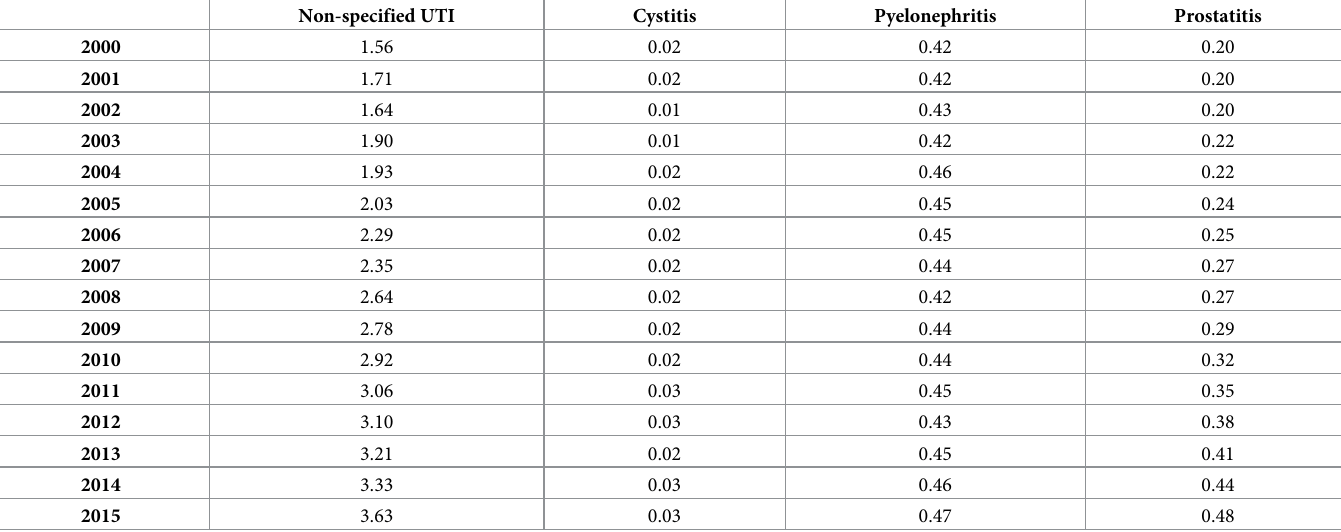
2008–2015; see S3 File. During the study period, two types of infection showed changes in trends: prostatitis- related hospitalizations in 2008 “Fig 6” and cystitis-related hospitalization in 2002 “Fig 4”; see S3 File. The APCs for prostatitis-related hospitalizations were 4.9% (95% CI 4.0; 5.7) annual from 2000–2008 and 9.0% (95% CI 8.2; 9.8) annual from 2008–2015. The APCs for cystitis- related hospitalizations were 5.1% (95% CI 3.6; 6.6) annual from 2002–2015. However, changes were not observed regarding pyelonephritis-related hospitalizations “Fig 5” see S3 File. Table 3. Hospitalization rates from 2000 to 2015, by UTI category per